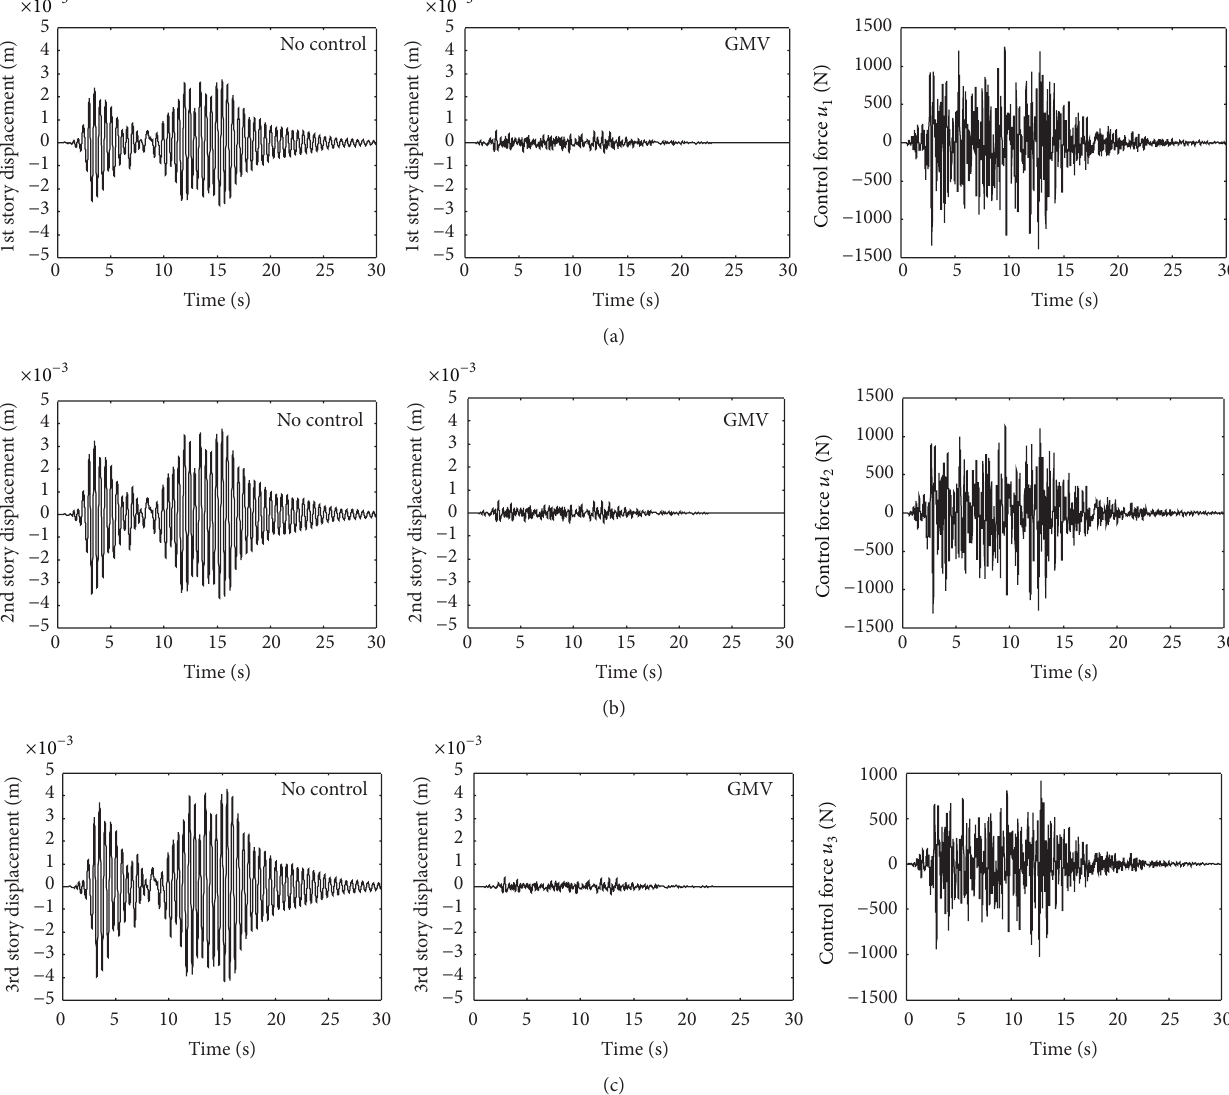
Figure 4: Structural response to Clough-Penzien ground acceleration. (a) 1st story, (b) 2nd story, and (c) 3rd